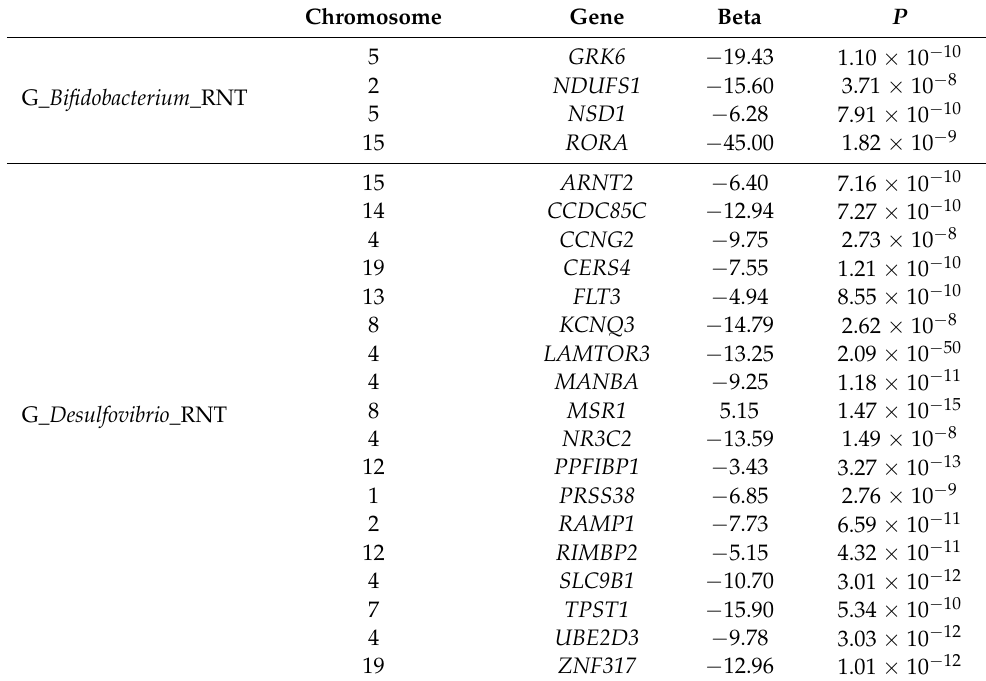
Table 2. Summary of interaction analysis between SNP and gut microbiota for neuroticism. Chromosome